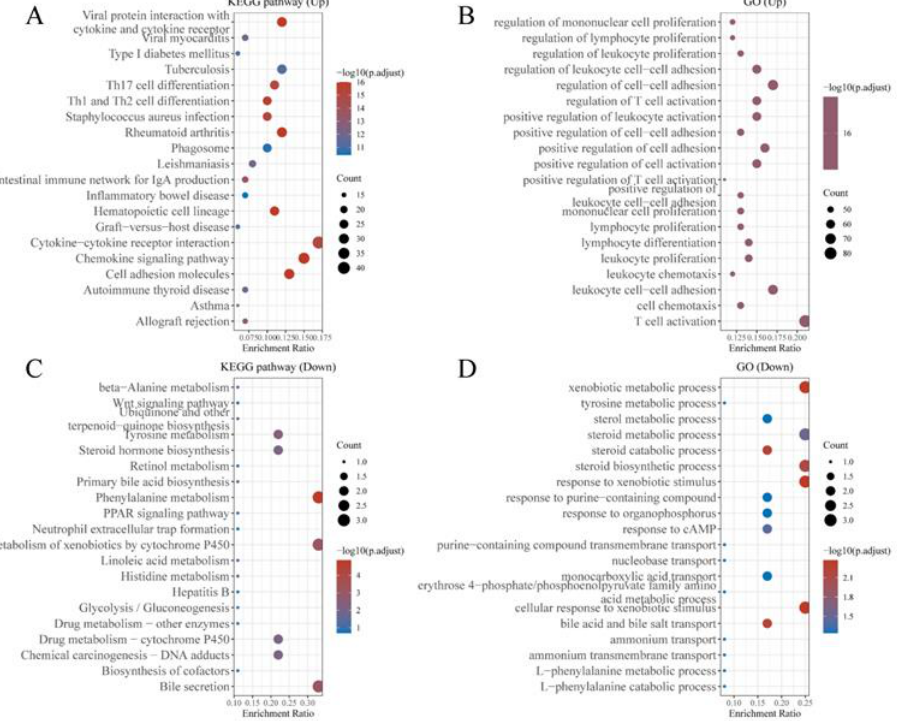
Figure 11. Enrichment results of LCK regulatory functions calculated using TCGA data: ( A ) KEGG pathways upregulated by LCK; ( B ) GO pathways upregulated by LCK; ( C ) KEGG pathways down- regulated by LCK; ( D ) GO pathways downregulated by LCK.